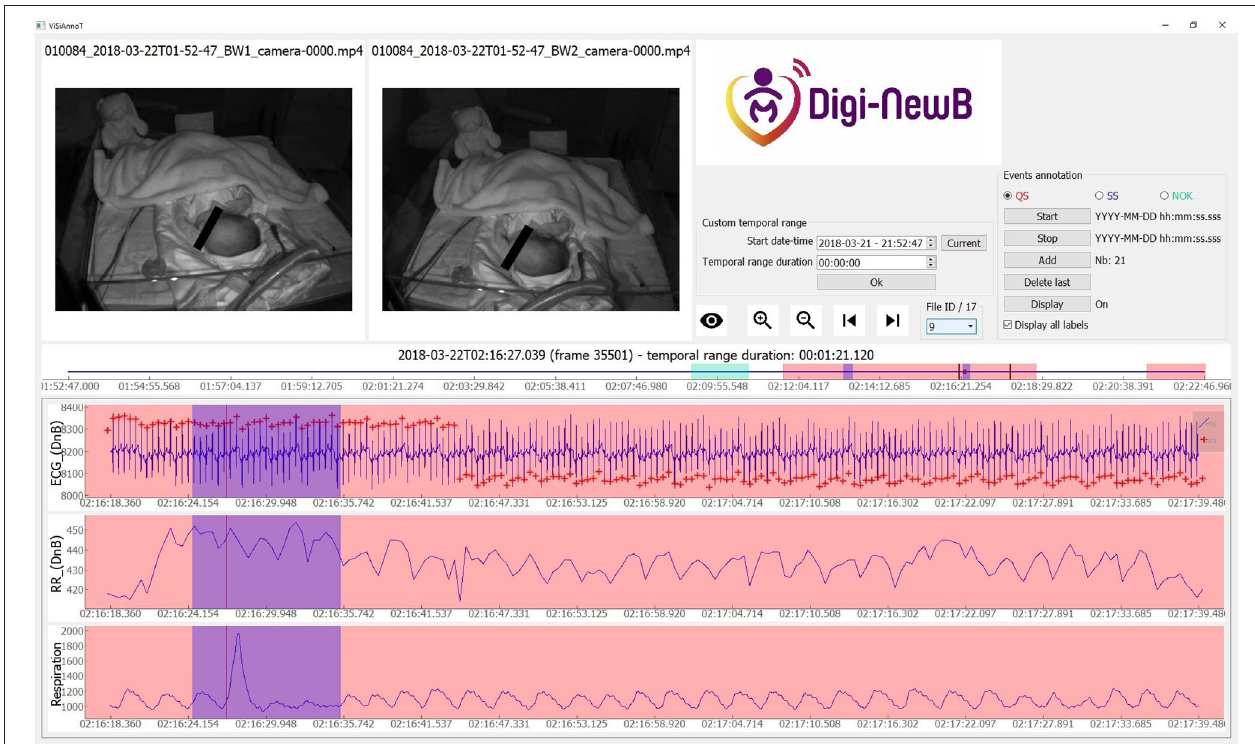
FIGURE 3 | Screenshot of ViSiAnnoT software illustrating a sigh in a newborn at 37 + 1 days PMA. There is a short interval of motion (visible in videos) with a modification of respiratory and ECG cycle for sigh. The annotated sigh intervals are highlighted in